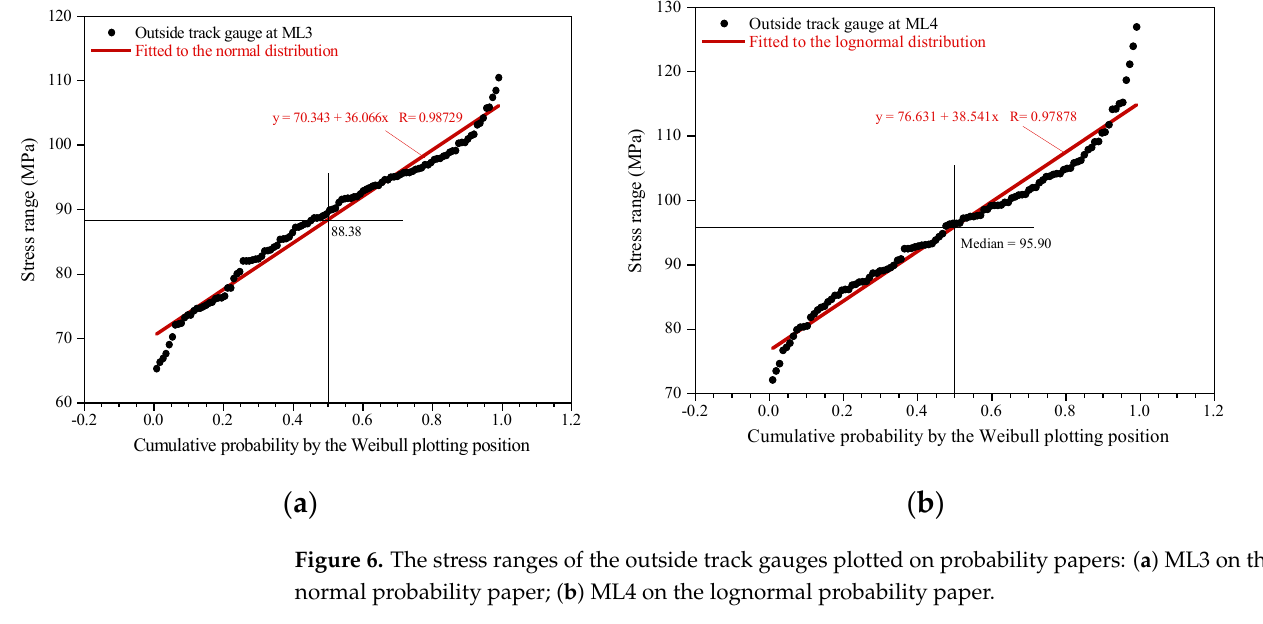
Figure 6. The stress ranges of the outside track gauges plotted on probability papers: ( a ) ML3 on the normal probability paper; ( b ) ML4 on the lognormal probability paper.